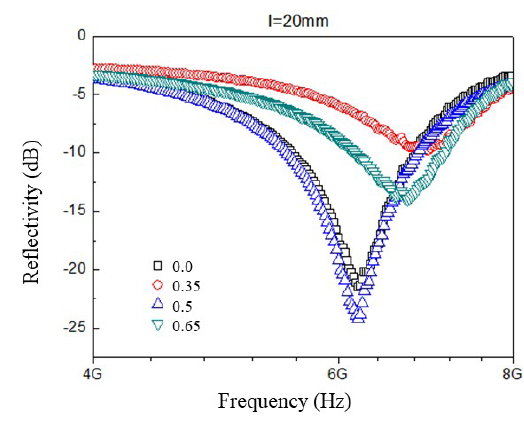
Zn Fe O ferrites with 1-x x 2 4